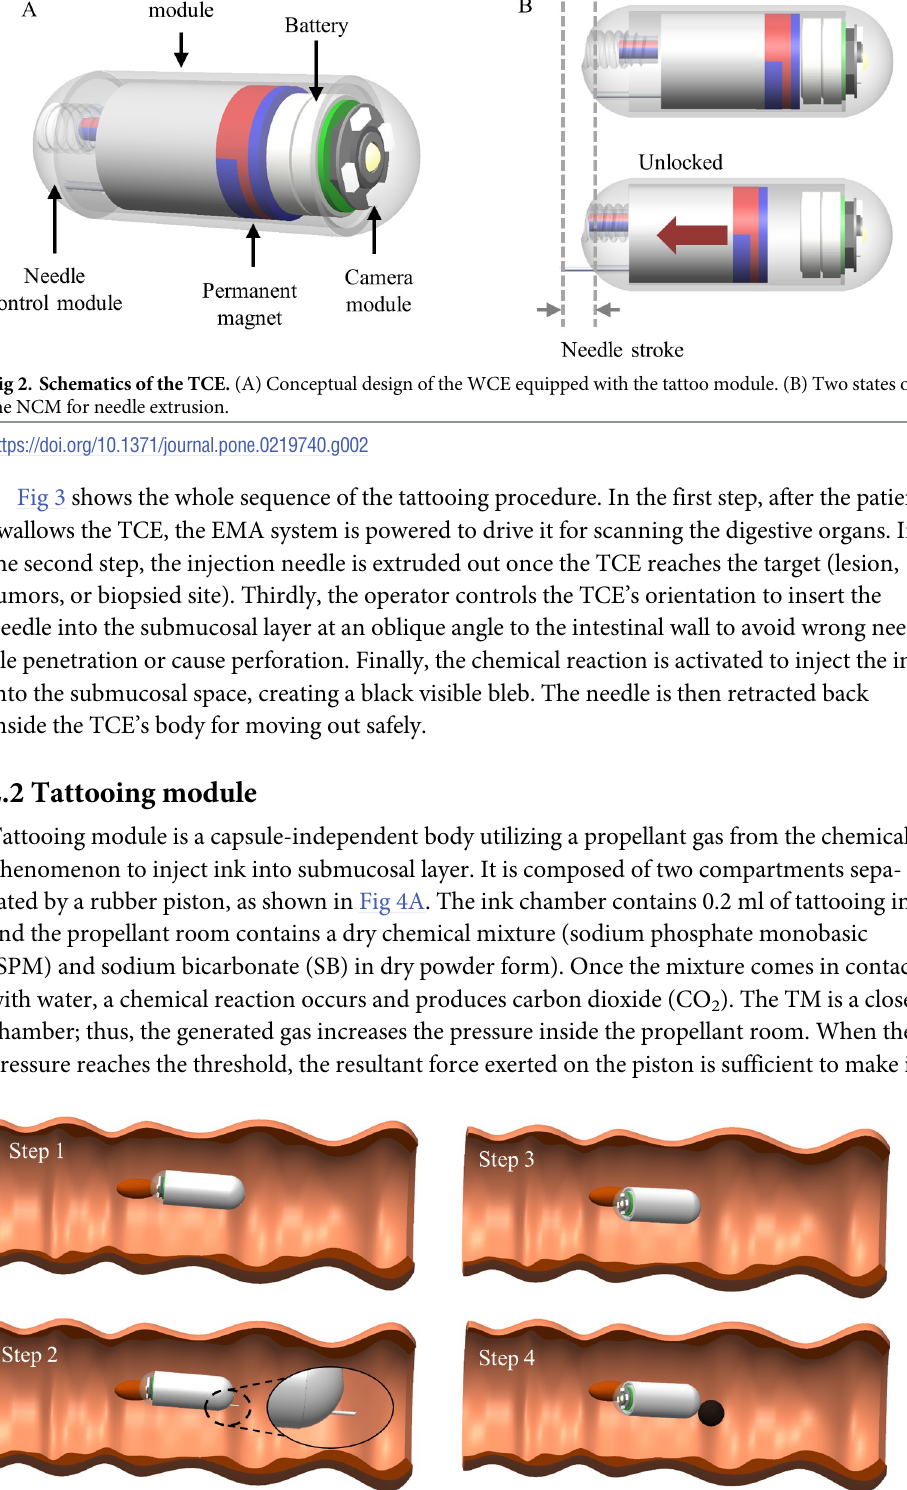
Fig 3. Tattooing procedure of the TCE controlled by the external magnetic